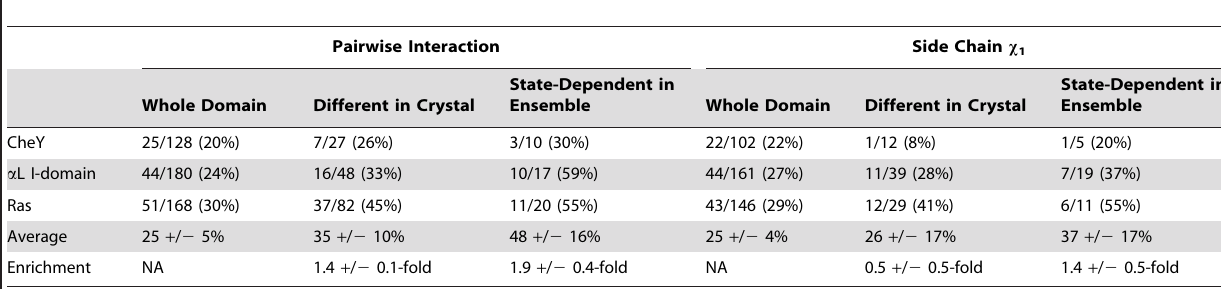
Table 2. Fraction of residues involved in pairwise interactions or side chain differences that are known to alter function.